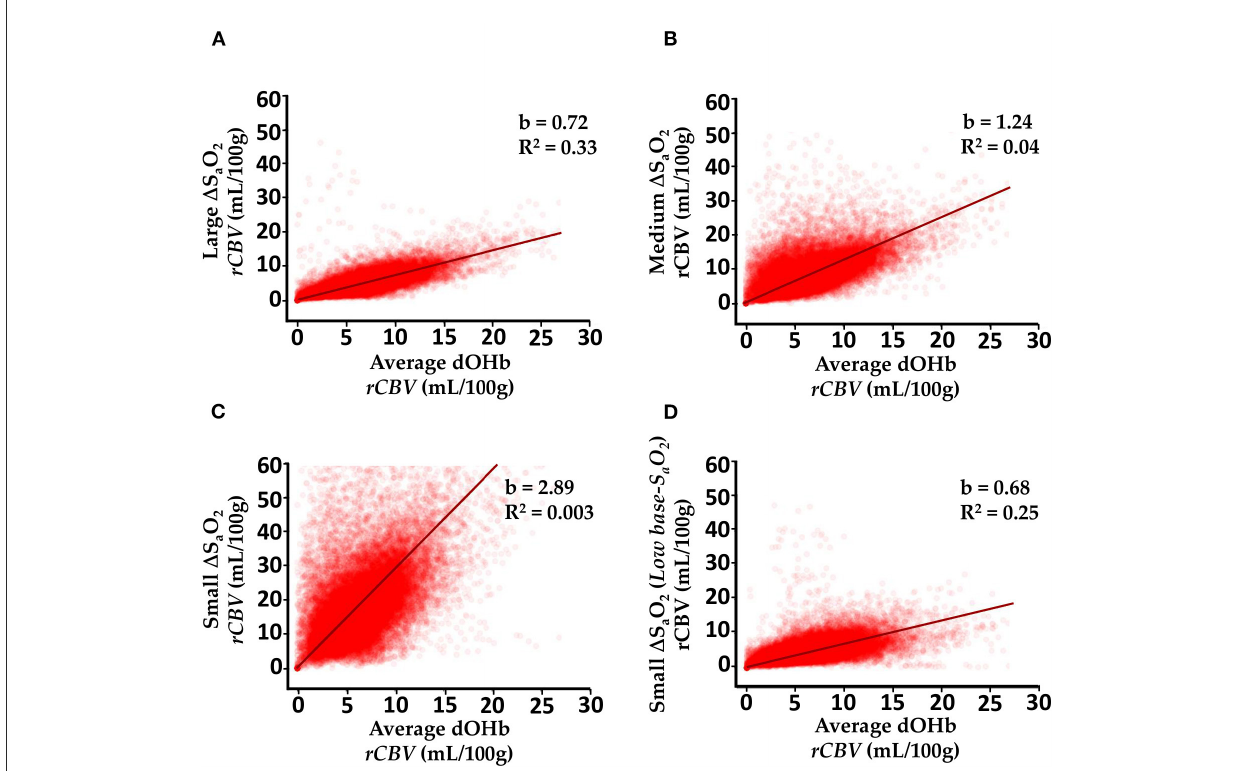
FIGURE8 Voxel-wise Comparison of Experimentally Calculated rCBV (mL/100g) From dOHb Paradigms. (A) Large 1 S a O 2 dOHb vs. average dOHb. (B) Medium 1 S a O 2 dOHb vs. average dOHb. (C) Small 1 S a O 2 dOHb vs. average dOHb. (D) Low base-S a O 2 dOHb vs. average dOHb. Each plot displays data from all GM and WM voxels in a single subject. b is the regression slope and R 2 is the coefficient of determination. Note that for this analysis specifically, rCBV maps were spatially smoothed with a 3x3 gaussian filter. The average dOHb paradigm is simply an average of the small, medium, and large 1 S a O 2